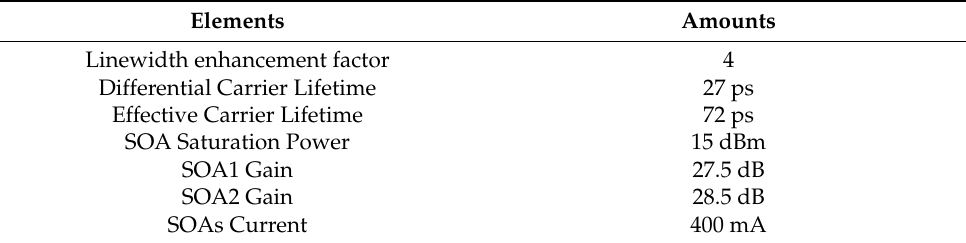
Table 1. The amounts of the SOAs element employed in the empirical and simulated setups. Elements Amounts Linewidth enhancement factor 4 Differential Carrier Lifetime 27 ps Effective Carrier Lifetime 72 ps SOA Saturation Power SOA1 Gain SOA2 Gain 28.5 dB SOAs Current 400 mA